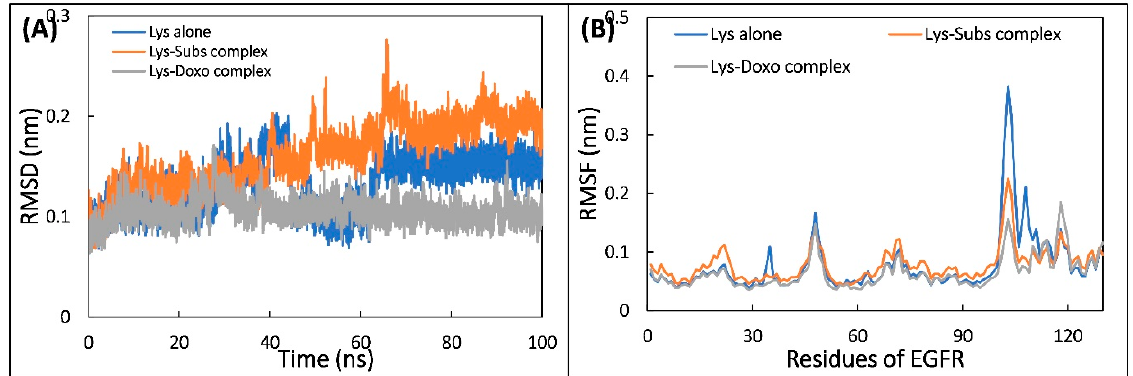
Figure 6. ( A ) The RMSD of backbone of lysozyme alone and lysozyme–substrate complex, and lysozyme–doxofylline complex during the simulation. ( B ) RMSF of C α atoms of lysozyme alone and in presence of substrate and doxofylline.